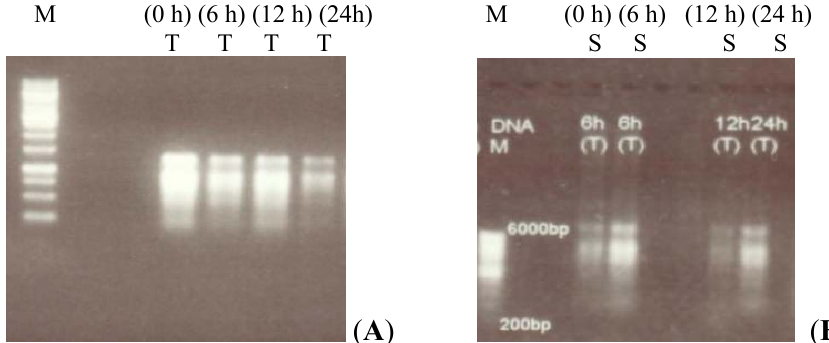
Figure 1. Representative total RNA extracted from root tissues of two canola lines differing in salt tolerance. ( A ) Total RNA isolated from root tissues of canola tolerant (T) line, harvested at 0, 6, 12 and 24 h after the induction of salt stress (control to salt treated plants). ( B ) Total RNA isolated from sensitive (S) canola line root tissues harvested at different time intervals. M is the 1 kb DNA